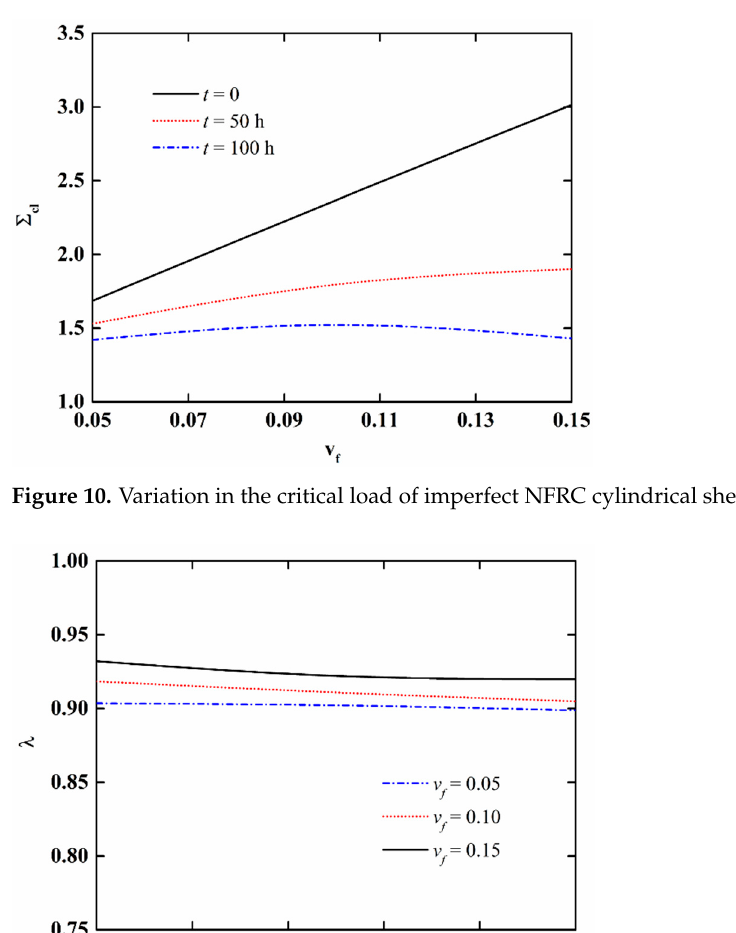
Figure 9. Variation in the critical load of imperfect NFRC cylindrical shells with aging time.